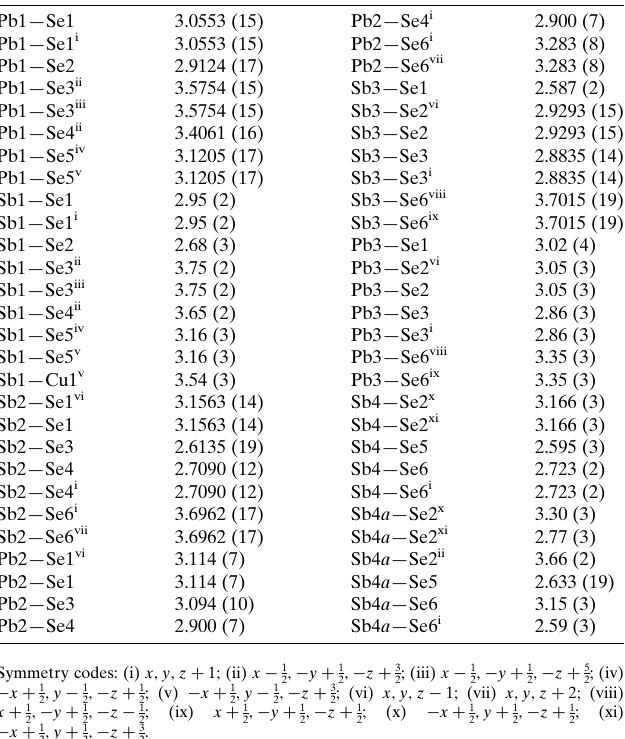
Table 1 Selected bond lengths (A˚ ).